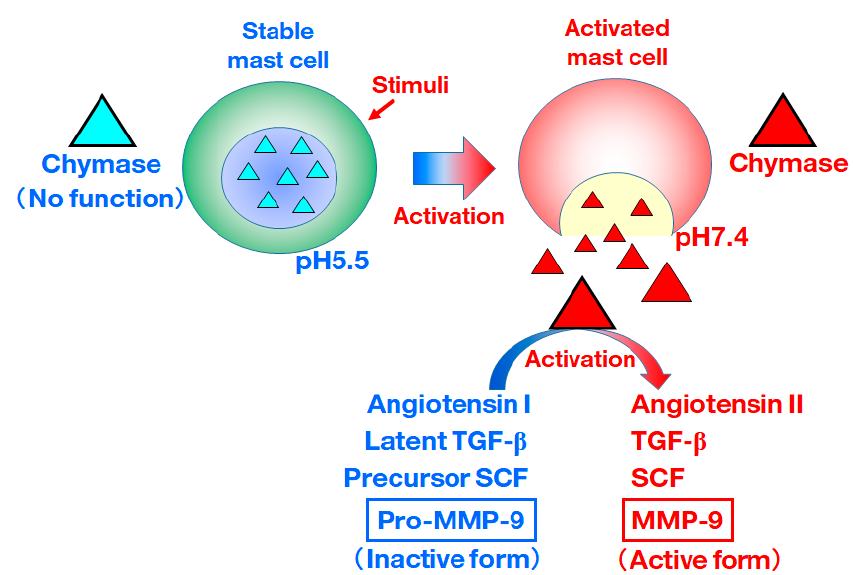
Figure 1. Chymase is stored in the secretory granules of inactive mast cells. The pH within granules is maintained at 5.5, at which the chymase has no enzymatic activity. Chymase exerts its enzymatic functions, such as activation of angiotensin II, TGF- β , SCF and MMP-9 from their respective precur- sors, upon release from mast cell granules, following activation by various stimuli.